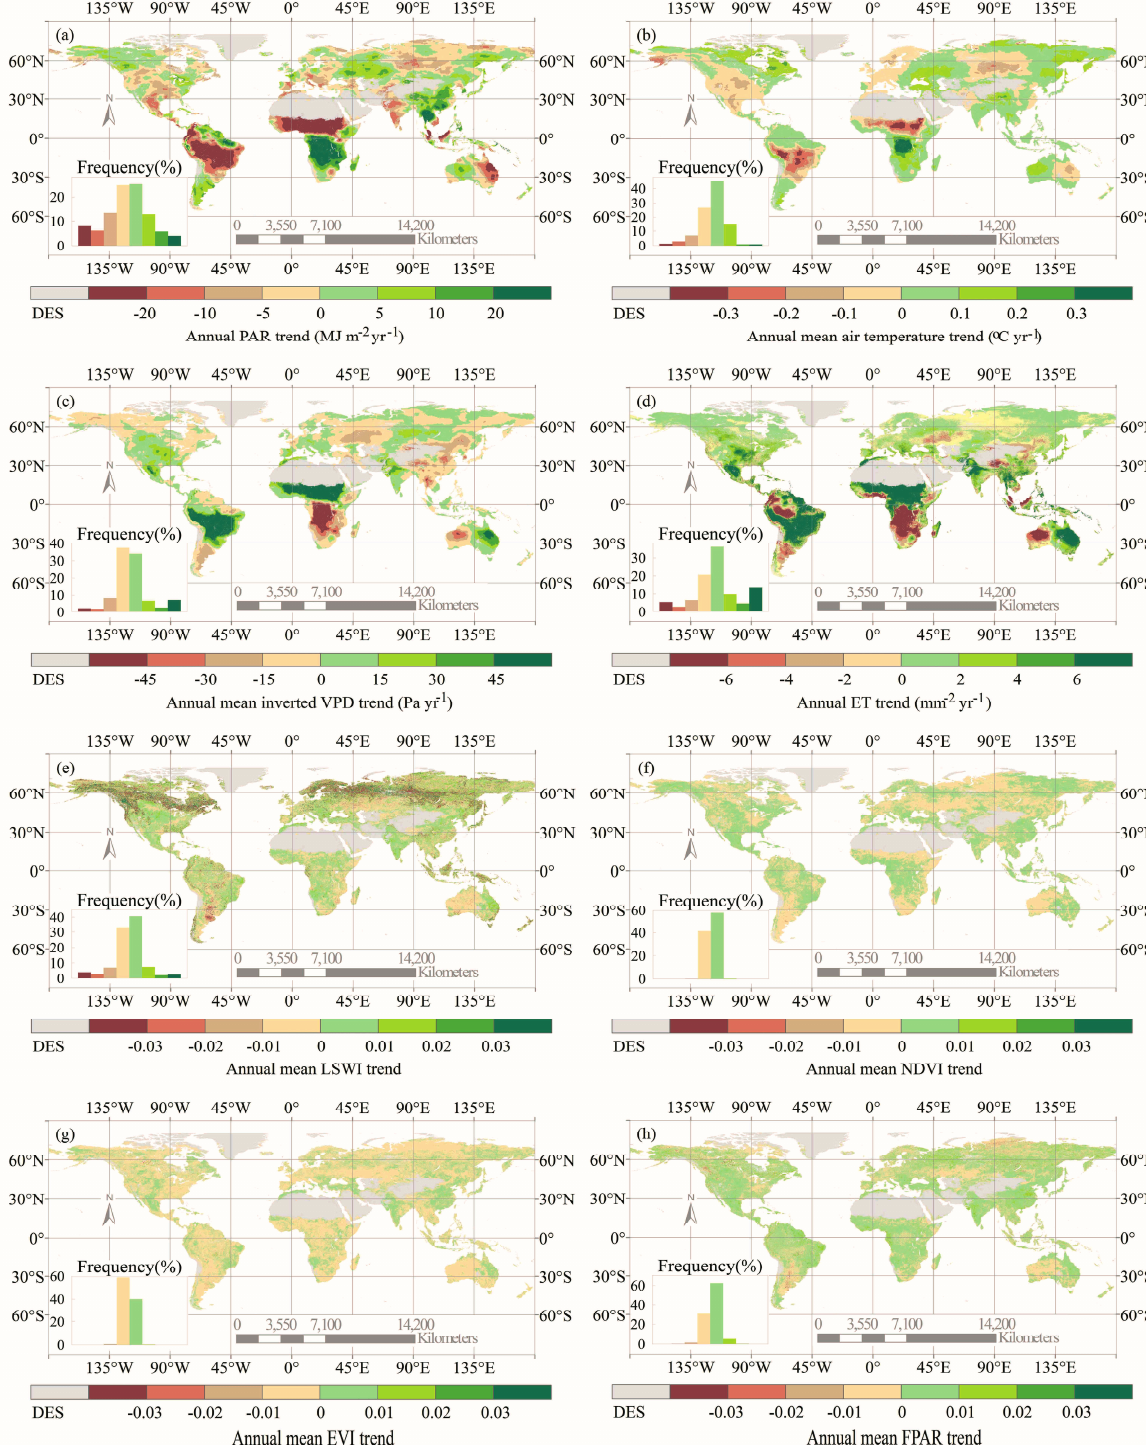
Figure 6. Spatial patterns on the change trends of environmental variables and vegetation indices: ( a ) Photosynthetically Active Radiation (PAR); ( b ) air temperature (Ta); ( c ) inverted Vapor Pressure Deficit (VPD); ( d ) evapotranspiration (ET); ( e ) Land Surface Water Index (LSWI); ( f ) Normalized Difference Vegetation Index (NDVI); ( g ) Enhance Vegetation Index (EVI); and ( h ) the Fraction of PAR absorbed by the vegetation canopy (FPAR). DES is no vegetation